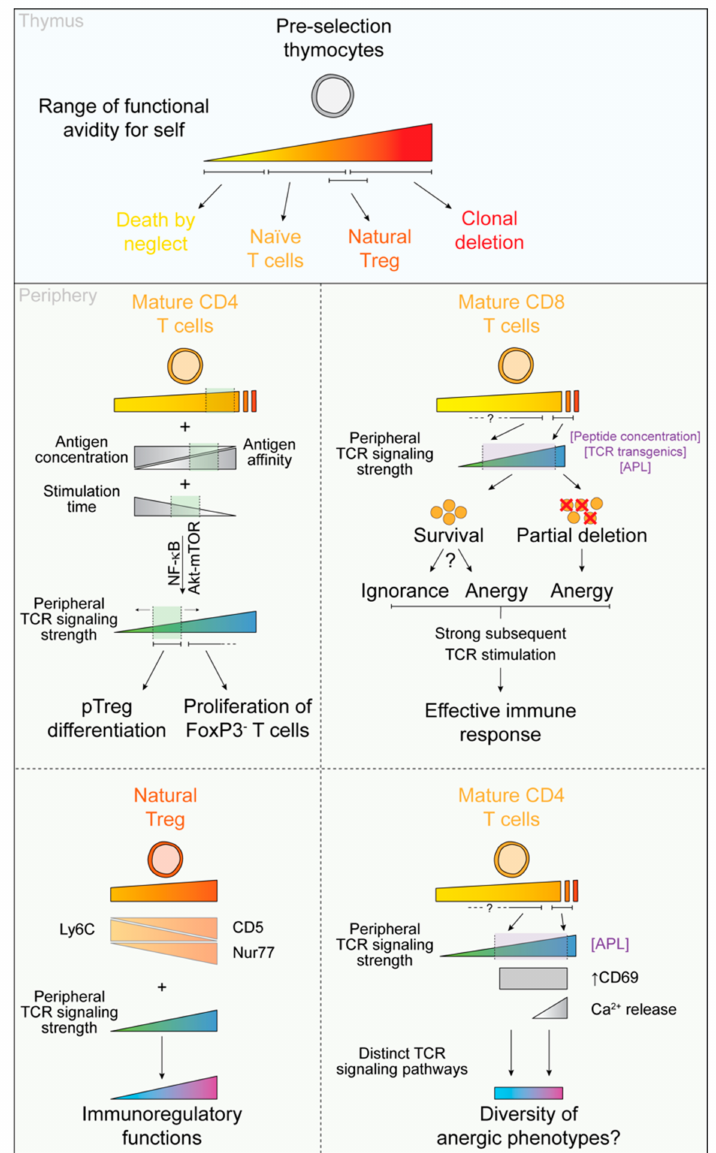
Figure 2. T cell receptor signal strength influences the ‘quality’ of Treg and anergic cells. (Top panel) During T cell development, αβ -lineage thymocytes test the reactivity of their T cell receptor (TCR)